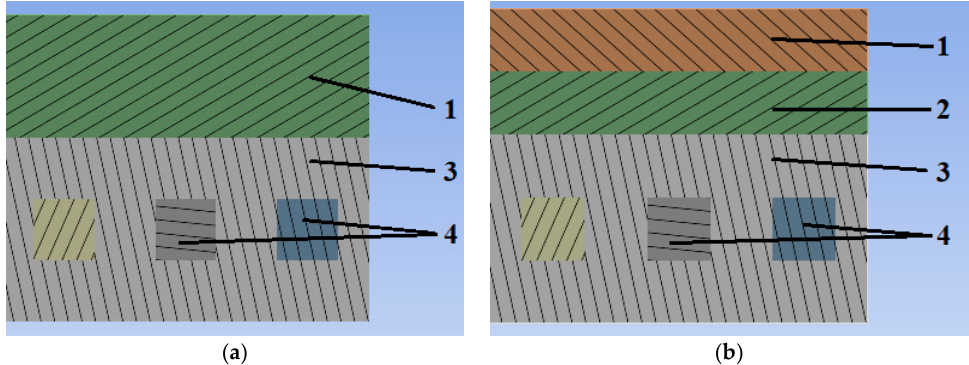
Figure 2. A vertical section of the models highlighting the different layers of both models: ( a ) The HPHS ( b ) The PCMHPHS: 1. First concrete layer. 2. PCM layer. 3. Second concrete layer. 4. Rectangular heat pipes.